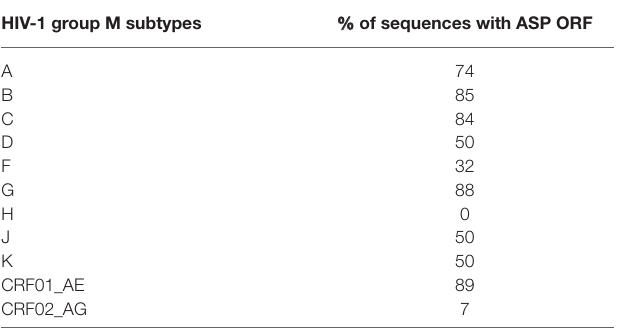
TABLE 1 | Fraction of the sequences displaying the AntiSense Protein Open Reading Frame (length >150 codons) within the main subtypes and circulating recombinant forms (CRFs) of HIV-1 group M (Cassan et al., 2016). HIV-1 group M